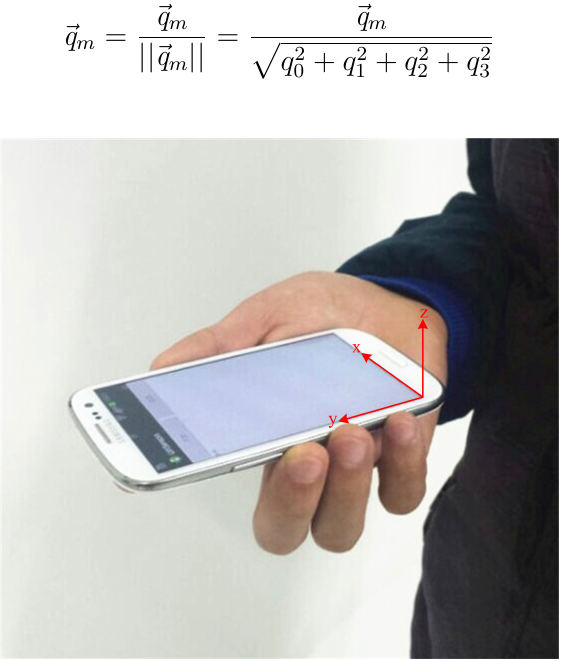
Figure 5. Local smartphone coordinate